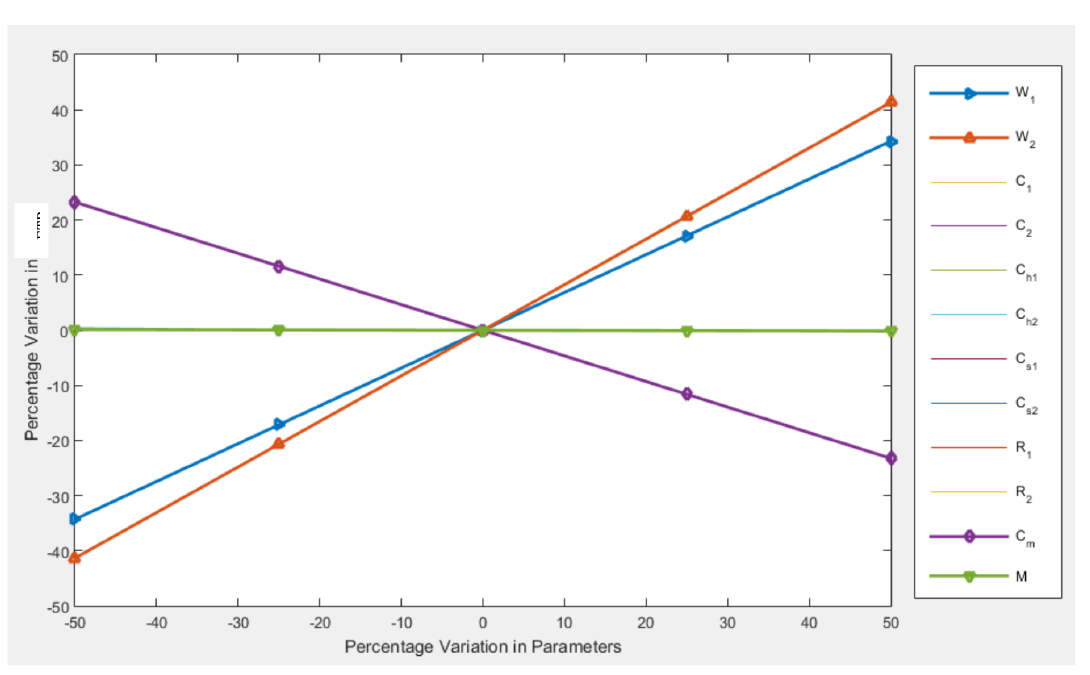
Figure 4. Variation in expected total profit per unit time (ETP) with variation in system parameters (selling price of first product w 1 , selling price of second product w 2 , inspection cost of first product C 1 , inspection cost of second product C 2 , holding of first product C h